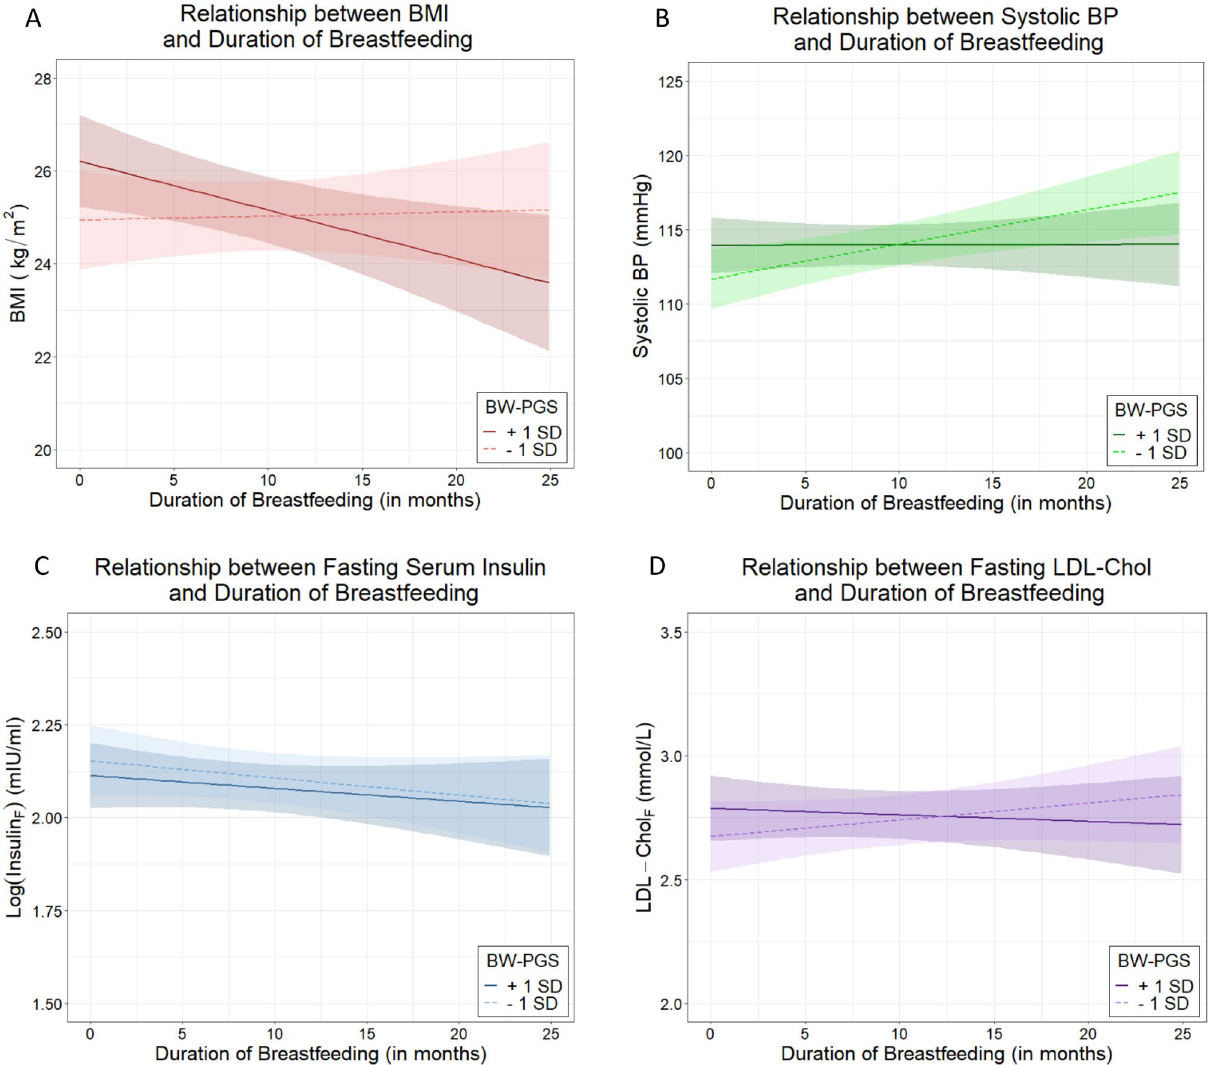
Figure 2. The relationship between duration of any breastfeeding and health measures for BW-PGS that is one standard deviation above the mean, and for BW-PGS that is one standard deviation below the mean. F denotes fasting. ( A ): Body mass index (BMI) at 22 years of age; ( B ): Systolic blood pressure (SBP) at 22 years of age; ( C ): Fasting insulin levels at 22 years of age; and ( D ): Fasting low density lipoprotein cholesterol (LDL-c) at 22 years of age (Figure generated using ggplot2 in Refs. 37,38